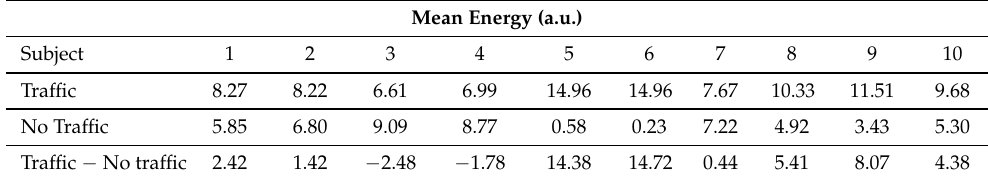
Table 2. Mean energy in the selected frequency range, computed considering the entire duration of the experiment (for all of the subjects). The numeric difference between them (with traffic–no traffic) is also reported. Mean Energy (a.u.)